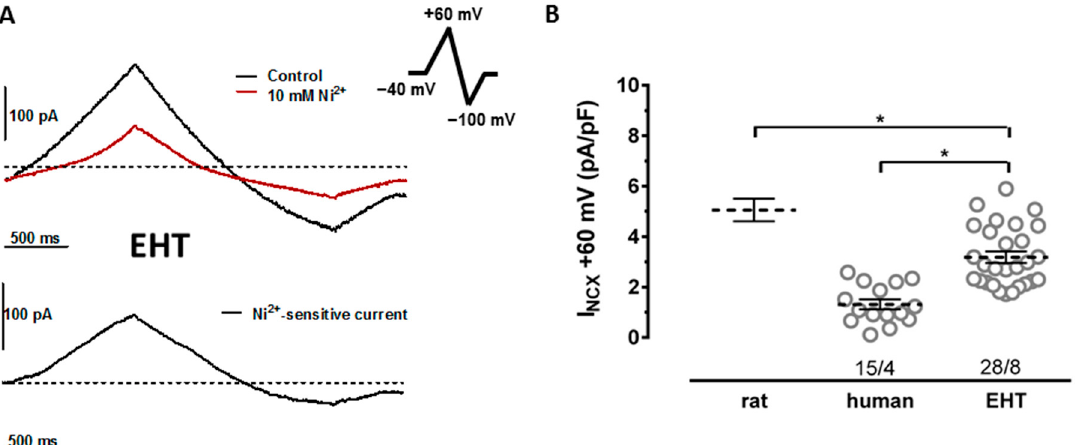
Figure 1. NCX currents in cardiomyocytes from rat ventricle, human ventricle, and EHT culture. ( A ) NCX current traces elicited by a ramp pulse from a holding potential of − 40 mV to +60 mV, then to − 100 mV, and back to the holding potential of − 40 mV (see inset) at the pre-drug control (black trace) and after superfusion of cells with 10 mM Ni 2+ (dark red trace). ( B ) NCX current density in the presence of 10 mM Ni 2+ given as individual data points (circles) and respective mean values ± SEM measured in CMs from human ventricle and EHT culture. For comparison of mean ± SEM NCX currents measured in rat ventricular, CMs from Christ et al. [7] are given. n/n indicates the number of cells/number patients for human and the number of cells/number of isolations for EHT, * indicates significance.